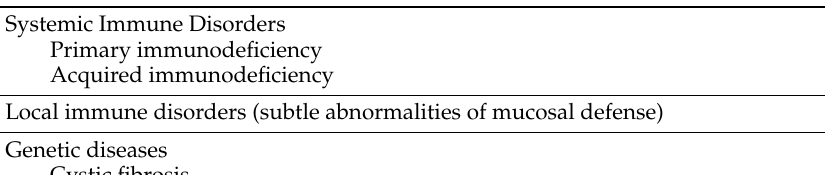
Table 4. Underlying causes of recurrent pneumonia affecting different/multiple lobes.